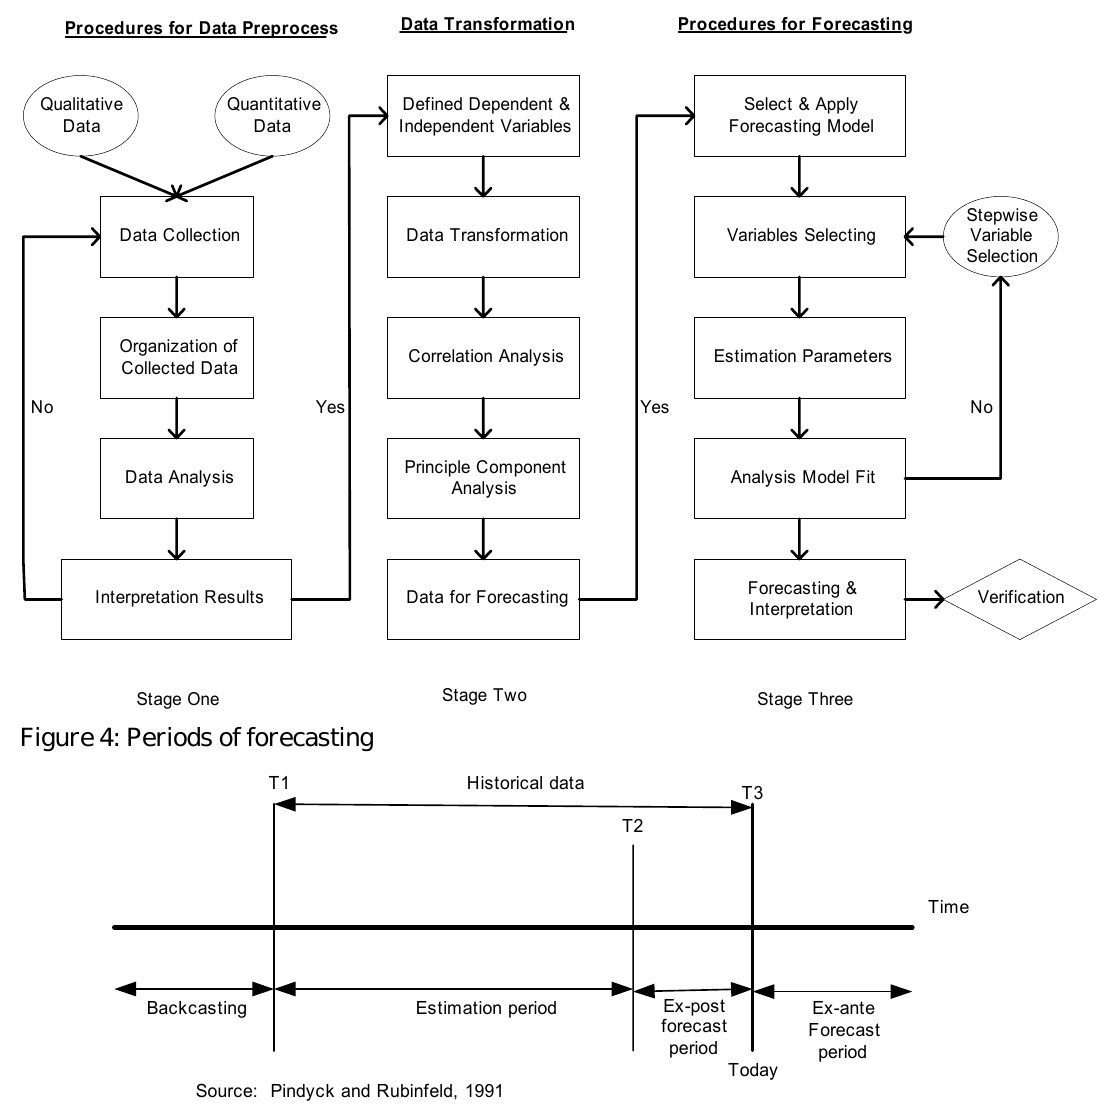
Figure 3: Depicts procedures for the housing prices forecast using log-linear model.